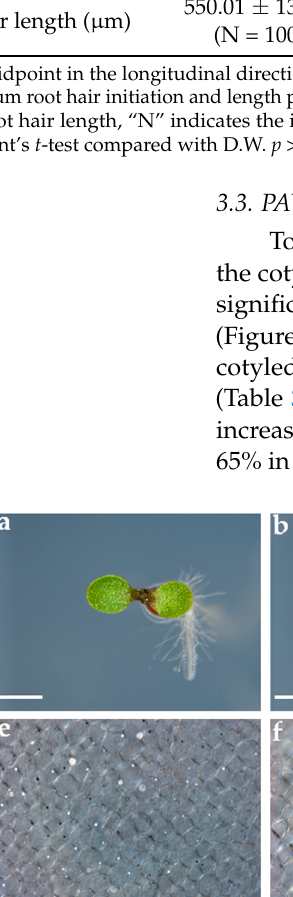
Table 2. Total root length, root hair number and root hair length A. thaliana L. (Col.0) 5 days after planting.